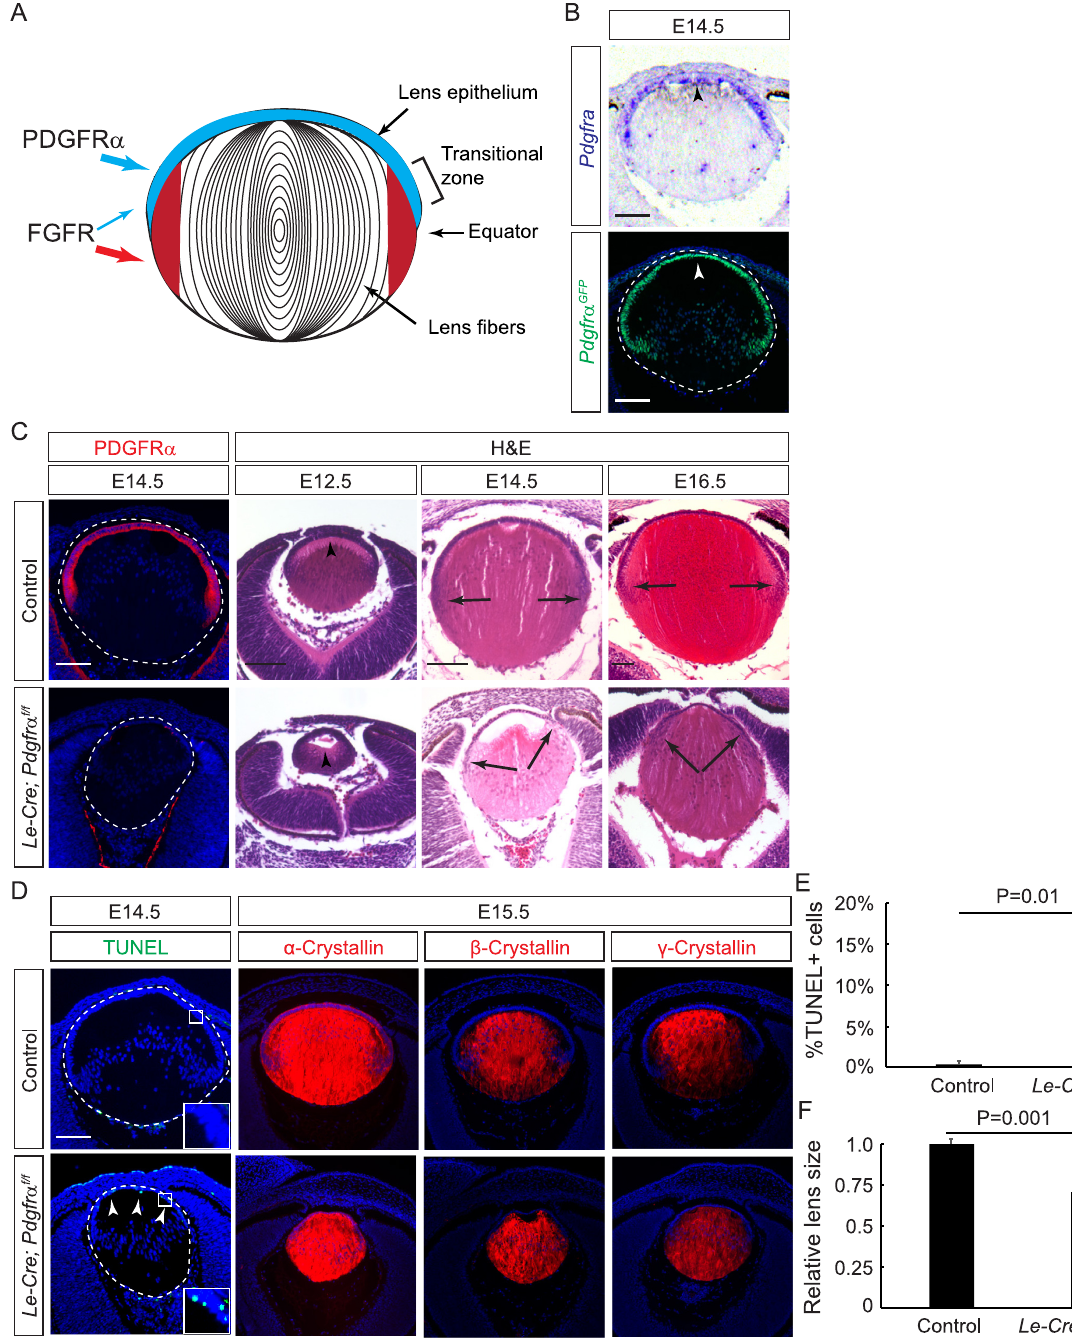
Fig 1. PDGFR α is essential for maintaining the lens epithelial cell population. (A) Schematic diagram of the mammalian lens. PDGFR α is expressed in the lens epithelial cells (blue), whereas FGFRs are predominantly expressed in the newly differentiated lens fiber cells (red). (B) In situ hybridization and immunofluorescence staining showed that Pdgfr α was expressed exclusively in the anterior epithelium of the E14.5 lens (arrowheads). (C) The Pdgfr α KO lens lost PDGFR α immunostaining by E14.5. The elongation of primary lens fiber cells was retarded at E12.5 (arrowhead), and the transitional zone was shifted anteriorly at E14.5 and E16.5 (arrows). (D) The Pdgfr α mutant lens displayed aberrant levels of apoptosis as indicated by TUNEL staining, while the expression of crystallins was unaffected. (E) Quantitation of TUNEL-positive cells as the percentage of total number of lens epithelial cells marked by DAPI at E14.5. Student t test, P = 0.01, n = 3 embryos. ( F ) Quantification of the relative lens size at E14.5. Student t test, P = 0.001, n = 4 embryos. Scale bars: 100 μ m. The numerical data used in panels E and F are included in S1 Data. E, embryonic day; FGF, fibroblast growth factor; FGFR, FGF receptor; HE, hematoxylin–eosin; KO, knockout; PDGFR α , platelet-derived growth factor receptor α .